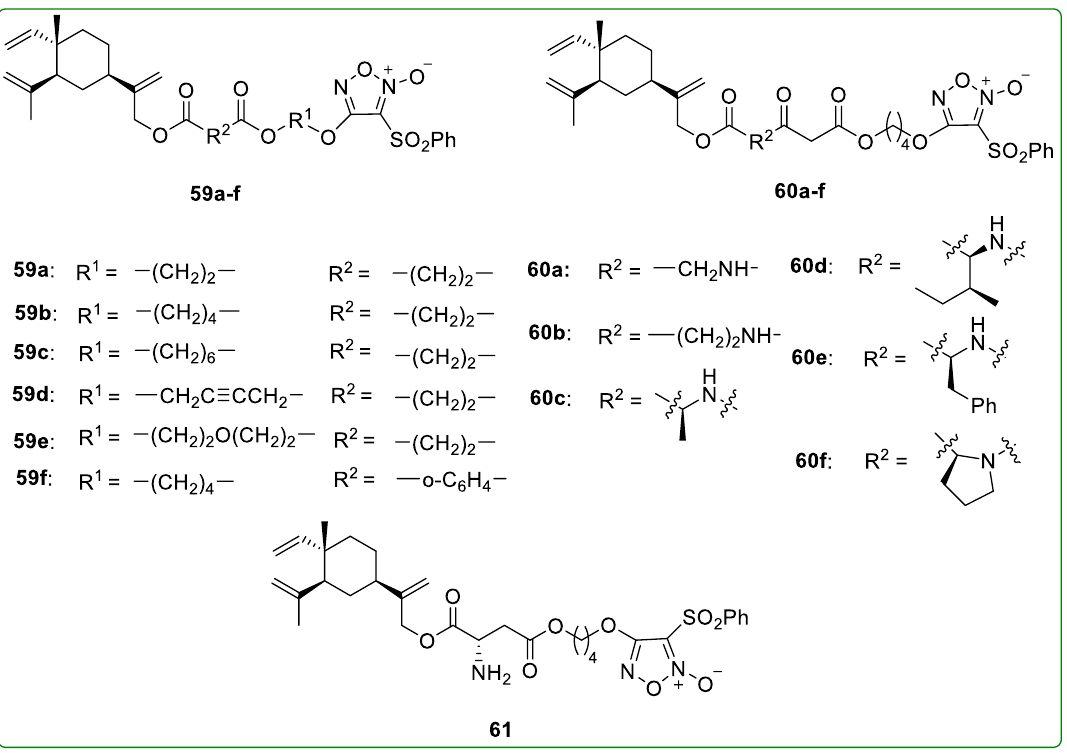
Figure 20. Chemical structures of β -elemene NO-donating derivatives 59 – 61 .